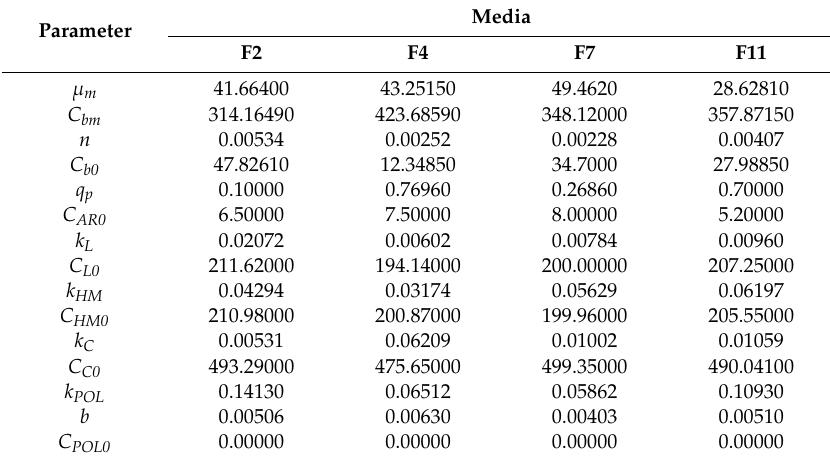
Table 4. Values of the kinetic parameters and initial concentrations corresponding to the equations of the model proposed that describe the variables measured in this